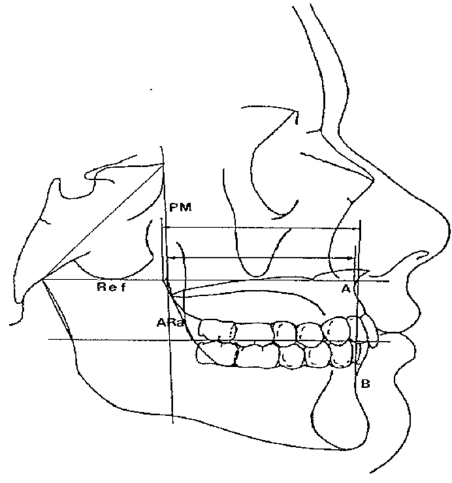
Figure 1. Maxillary/mandibular skeletal arches at A/B.